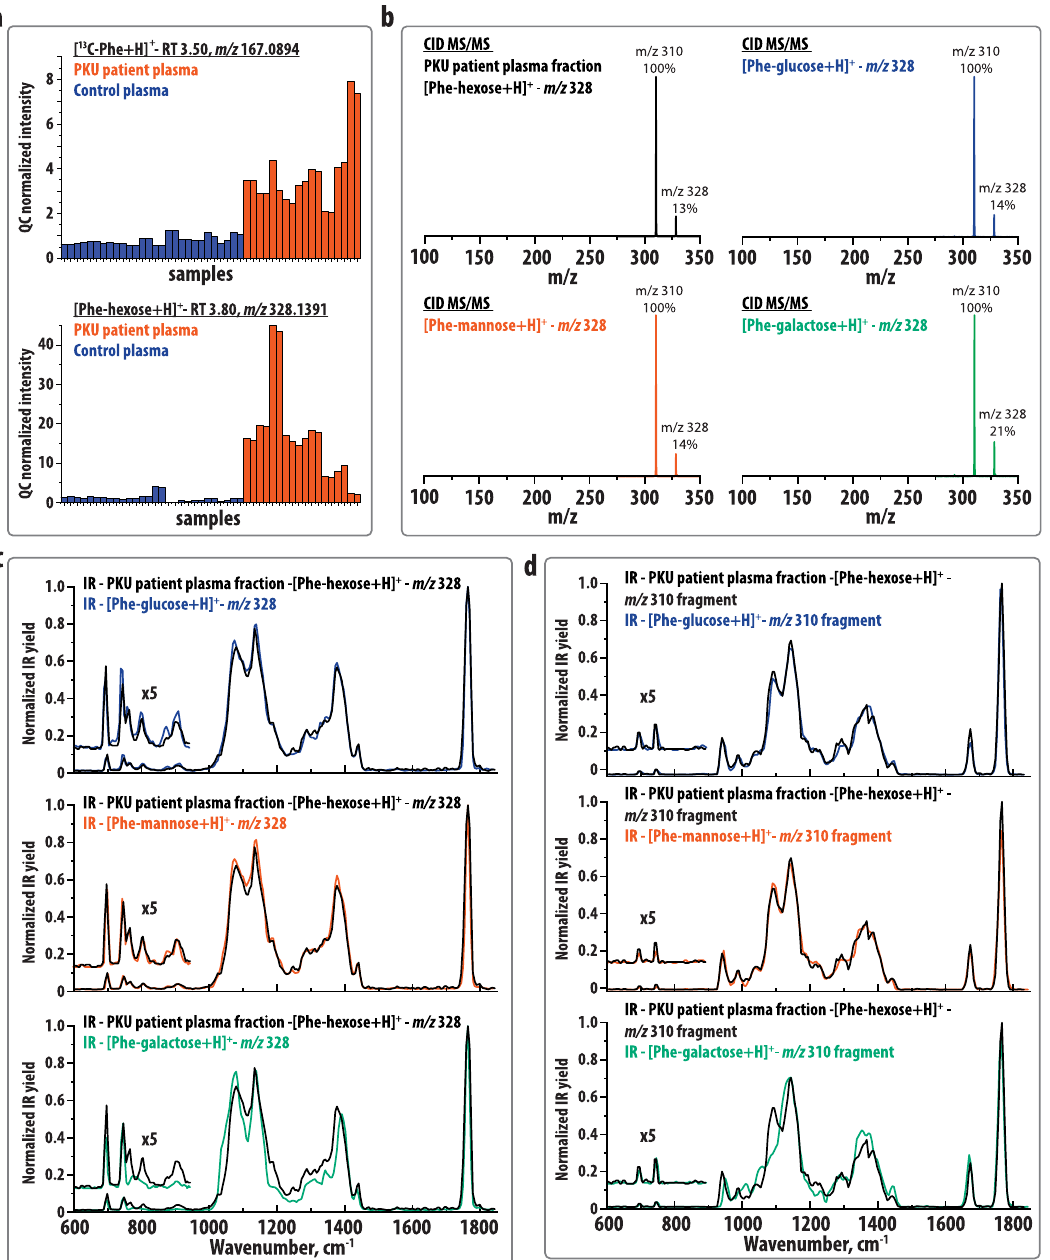
Fig. 1 Overview of LC-MS and IRIS experiments. a Intensity plot of protonated 13 C-Phe ( m/z 167.0897) and the Phe-hexose ( m/z 328.1391) observed in nine plasma samples of PKU patients (red) and 14 control plasmas (blue). Each sample was analyzed as two technical replicates, shown as consecutive bars in the fi gure. The ordering of samples is the same in both panels. The average fold changes (PKU patient/control) of Phe and the Phe-hexose are determined at 5 and 14, respectively. Comparison of b collision-induced dissociation (CID) MS/MS spectra and c IRIS spectra of the protonated ions ([M + H] + , m/z 328) of the Phe-hexose isolated from PKU patient plasma and the Phe-glucose, Phe-mannose, and Phe-galactose reference standards. d Comparison of the IRIS spectra of the water-loss fragments of the protonated ions ([M + H – 18] + , m/z 310) of the Phe-hexose isolated from PKU patient plasma and the three reference